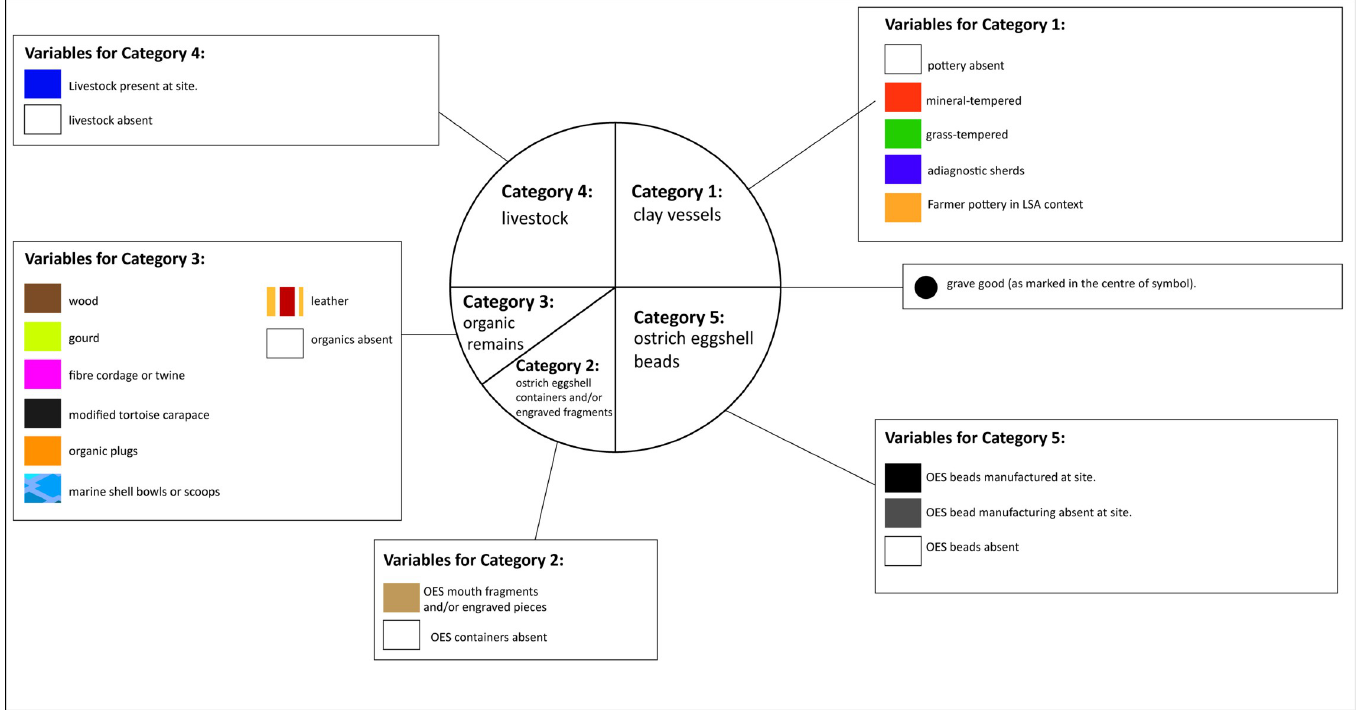
Fig 4. The symbol used to display the five categories of archaeological material found at a site.